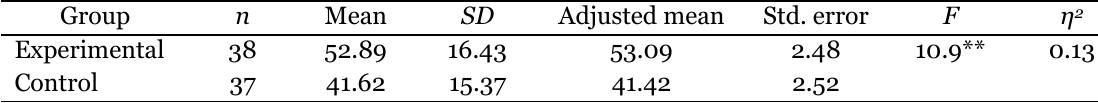
ANCOVA Results for Learning Performance in Experiment